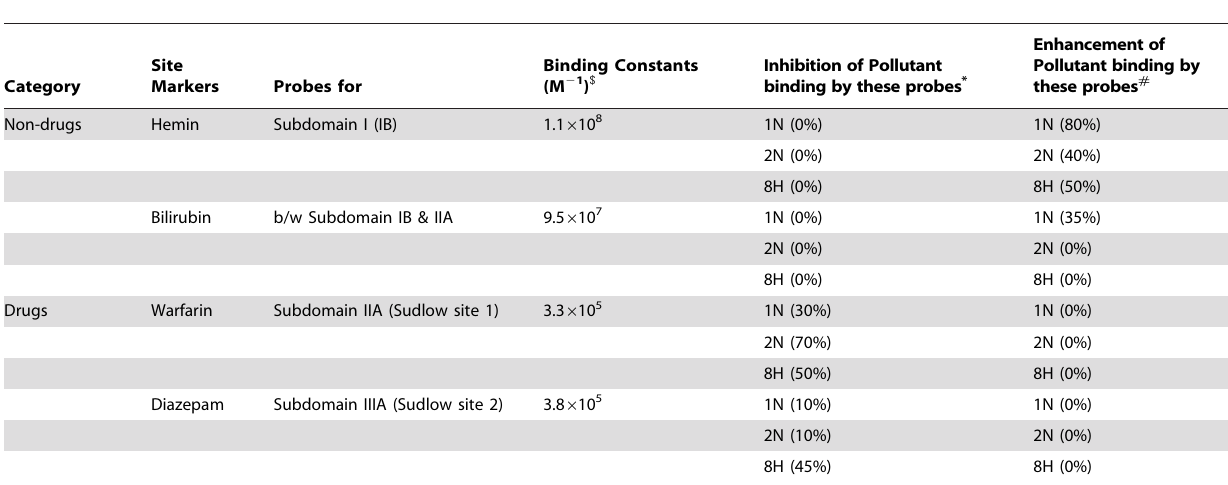
Table 5. The competitive experiments of HSA–pollutant system with different site